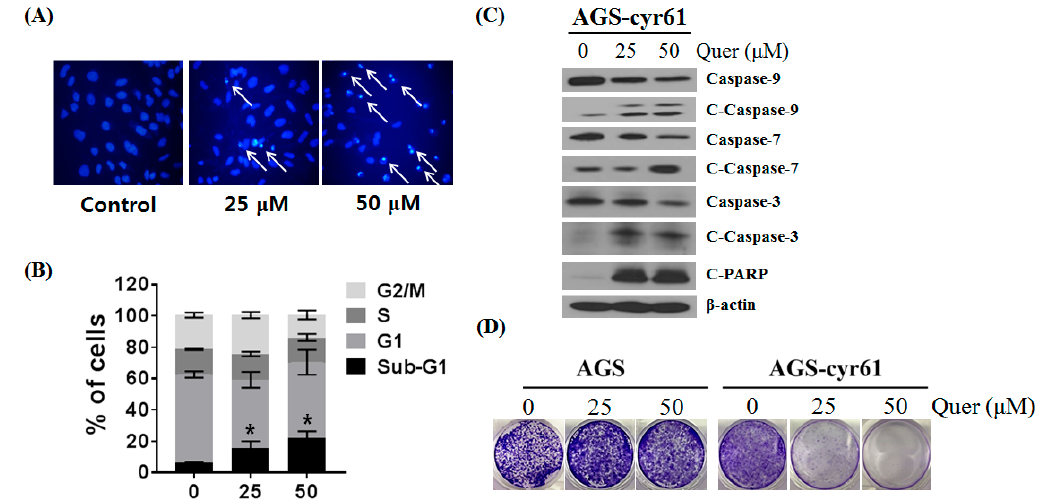
Figure 3. Quercetin induces apoptosis and inhibits colony formation in AGS-cyr61 cells. ( A ) Cell apoptosis observed using Hoechst 33342 staining. AGS-cyr61 cells were treated with quercetin (0, 25, and 50 μ M) for 24 h. Apoptotic cells exhibited nuclear morphological changes typical of apoptosis. The stained nuclei were visualized under a fluorescence microscope. Arrows represent apoptotic cells; ( B ) AGS-cyr61 cells were treated with quercetin (0, 25, and 50 μ M) and fixed after 24 h for flow cytometry. Propidium iodide-labeled nuclei were analyzed for DNA content. The sub-G0/G1 apoptotic population and the G1, S, and G2/M phase populations were quantified using DNA histograms. The data shown are representative of three independent experiments that gave similar results. * p < 0.05 compared with the AGS-cyr61 cell control; ( C ) Quercetin induces apoptosis via a caspase-dependent apoptosis pathway in AGS-cyr61 cells. AGS-cyr61 cells were treated with quercetin for 24 h; ( D ) Colony formation ability assay with quercetin for 5 days in AGS and AGS-cyr61 cells. AGS and AGS-cyr61 cells were stained using crystal violet for 30 min.